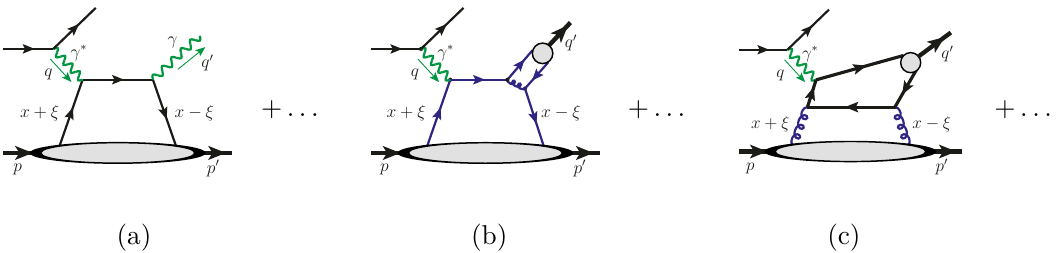
Figure 1. Sample two-scale observables from exclusive deeply virtual lepton-hadron scattering: (a) deeply virtual Compton scattering (DVCS), (b) deeply virtual meson production (DVMP), and (c) deeply virtual heavy quarkonium production